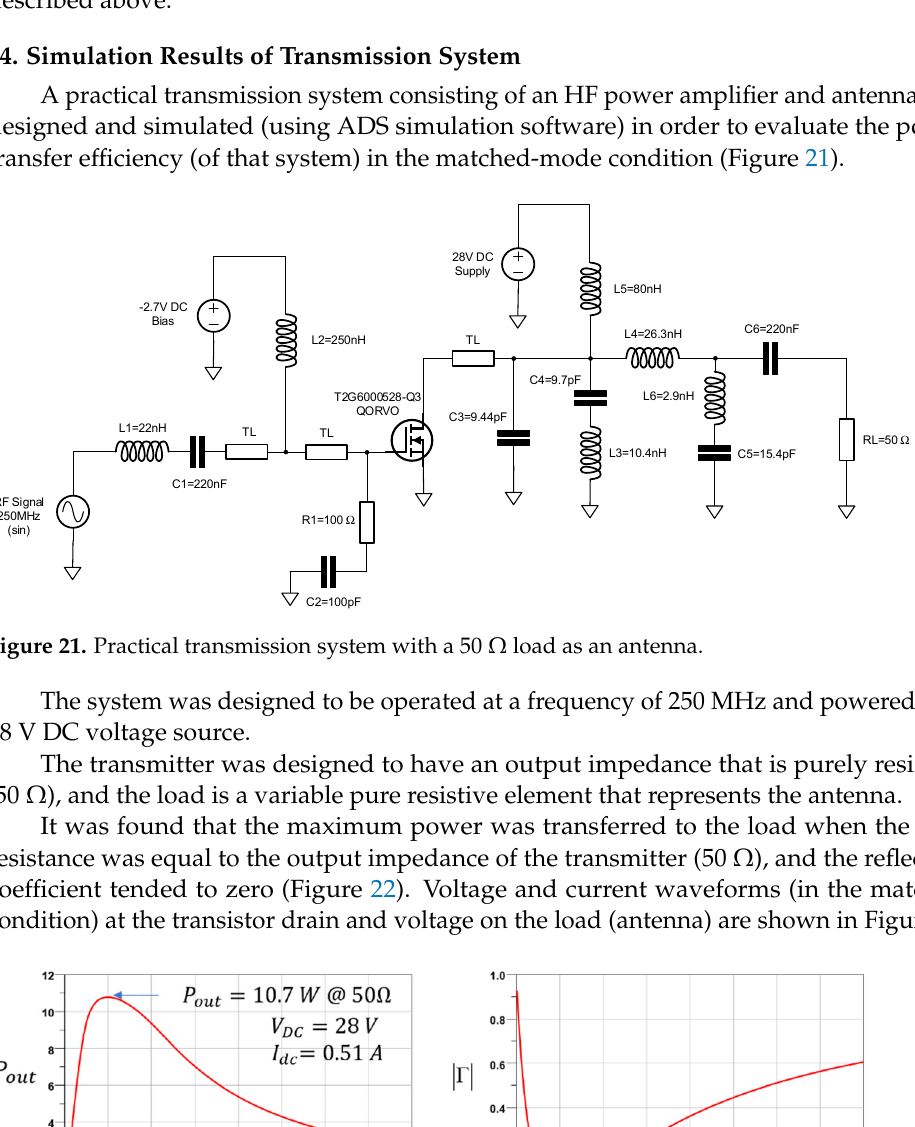
Figure 22. The output LFR power as a function of the load resistance ( a ). The absolute value of the Γ reflection coefficient as a function of the load resistance ( b ).